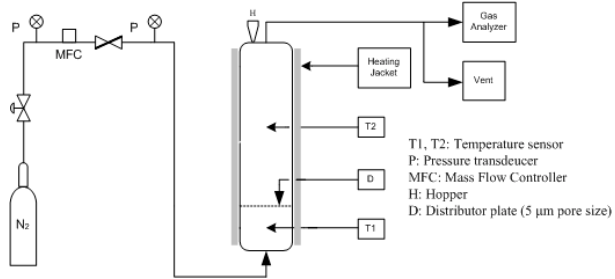
Figure 2. Schematic diagram of the fluidized bed used in this study.